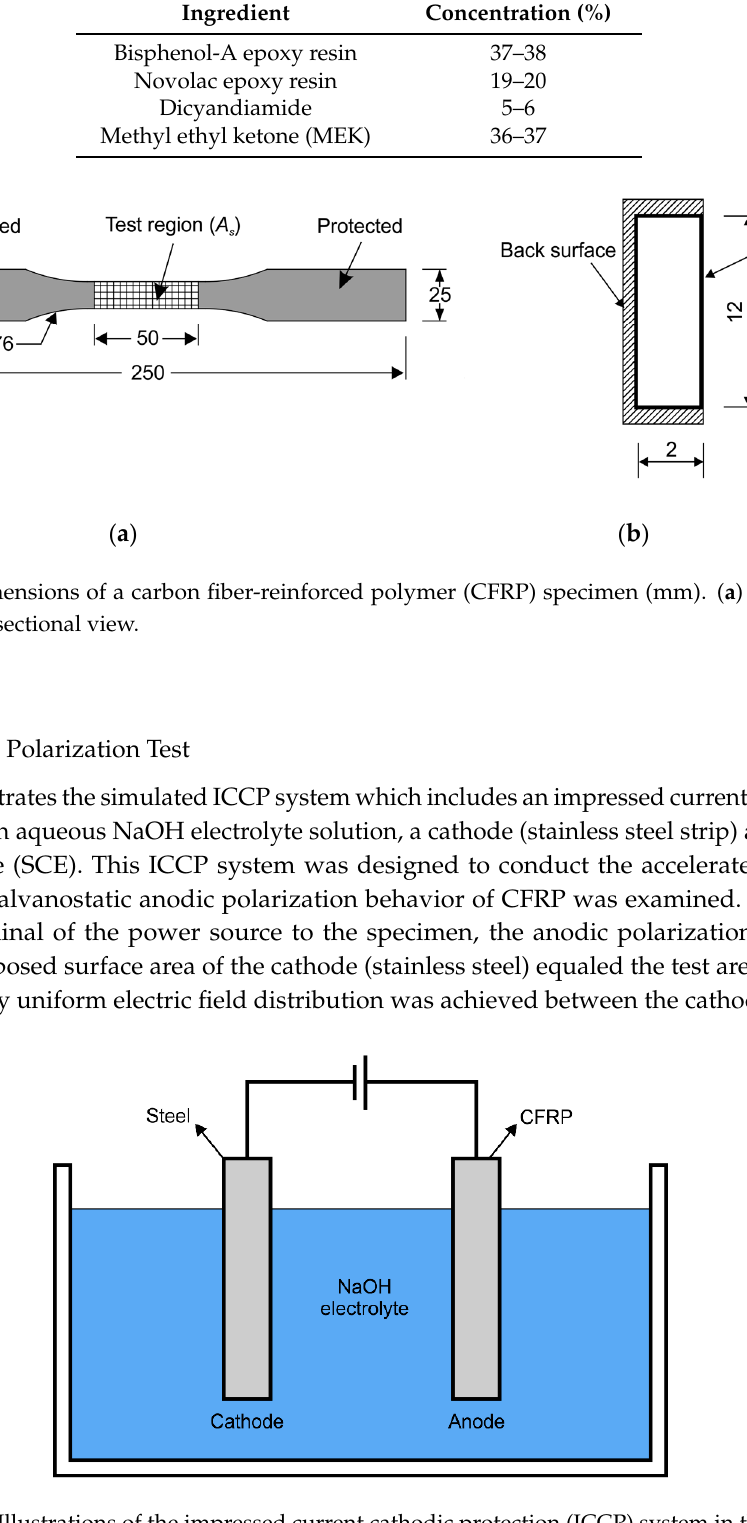
Figure 2. Illustrations of the impressed current cathodic protection (ICCP) system in the test. Galvanostatic anodic polarization was achieved by supplying a constant current. Different nominal current densities of 0, 0.77, 1.54, 3.08, and 6.15 A/m 2 were controlled by applying